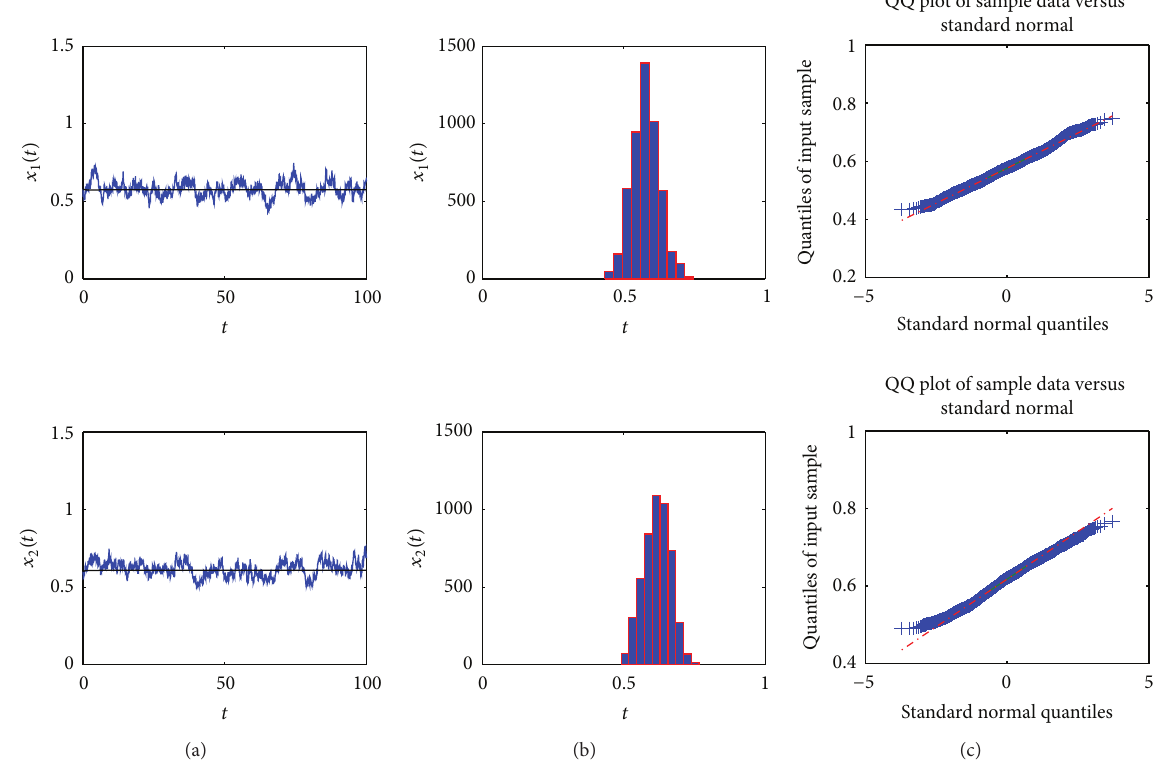
Figure 1: The pictures on the left are the solutions of stochastic system (73) and the corresponding undisturbed system, and the blue lines and the black lines represent them, respectively. The middle of the subgraphs is the histogram of stochastic system (73) and the subgraphs on the right are normal quantile-quantile plots of the values of the paths 𝑥 1 (𝑡) and 𝑥 2 (𝑡) . The stochastic system is stochastically permanent and has a stationary distribution. 𝜎 1 = 0.1 , 𝜎 2 = 0.09